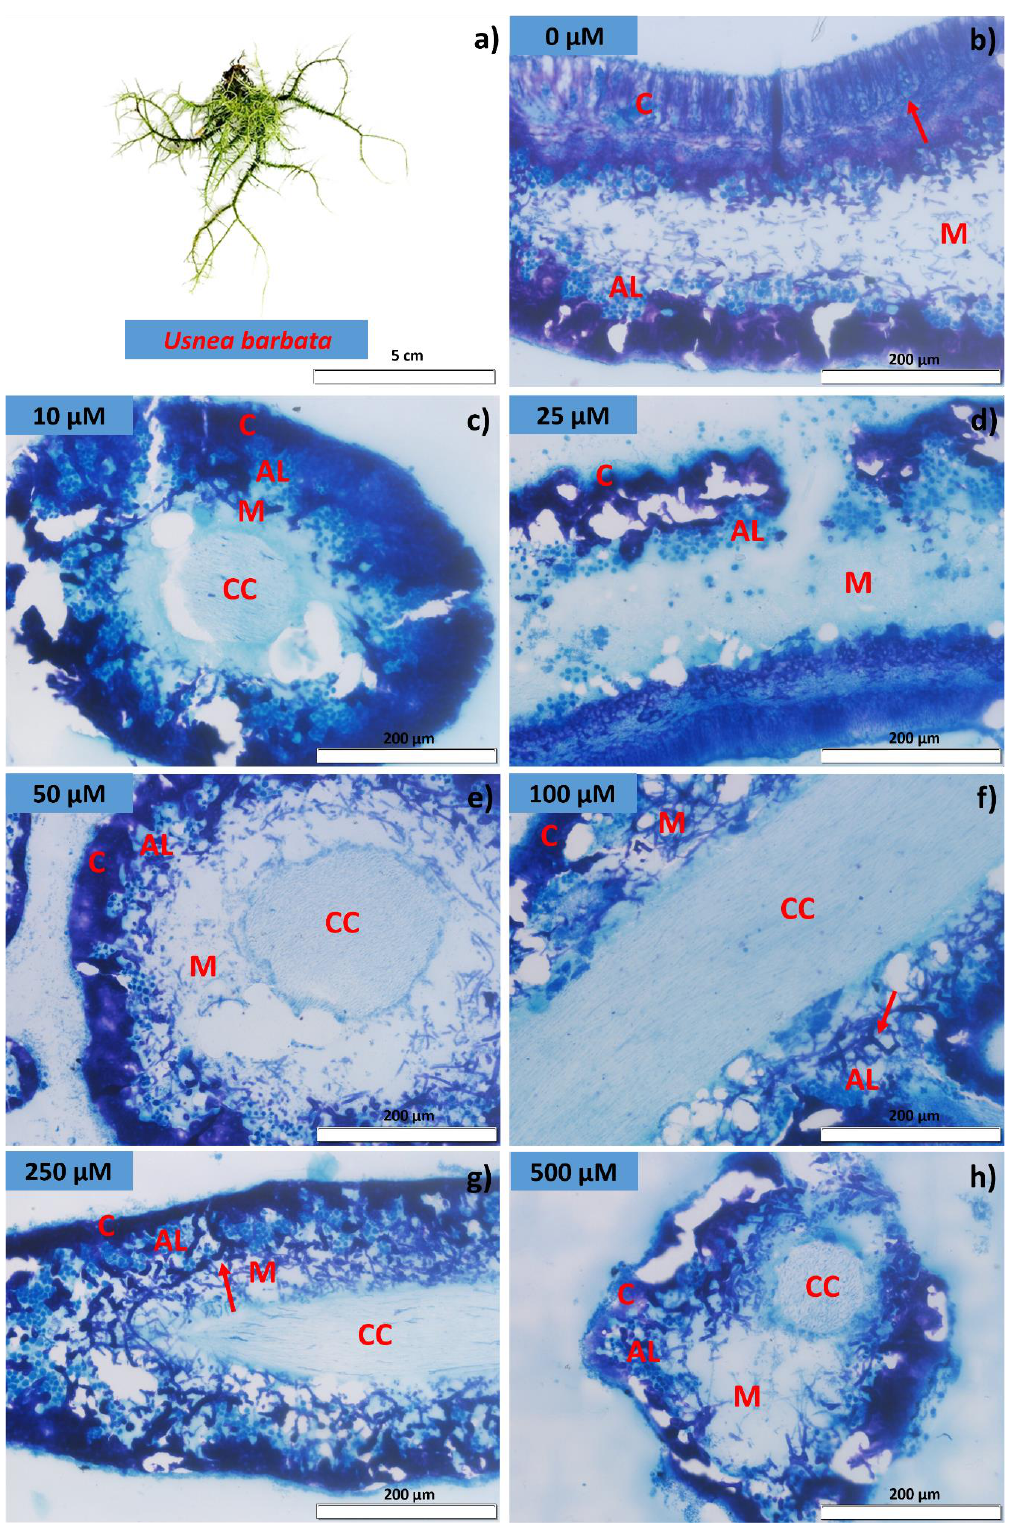
Figure 3. Anatomical sections show the tissue organization of Usnea barbata thallus subjected to different concentrations of the heavy metal cadmium (0, 10, 25, 50, 100, 250, and 500 µ M). Usnea barbata ( a ). In ( b ), the arrow indicates the presence of ascospores stored in asci. In ( b – h ), C = cortex, AL = algal layer, M = medulla, and CC = central cylinder. In ( f , g ), the arrow indicates the intensely stained medullary